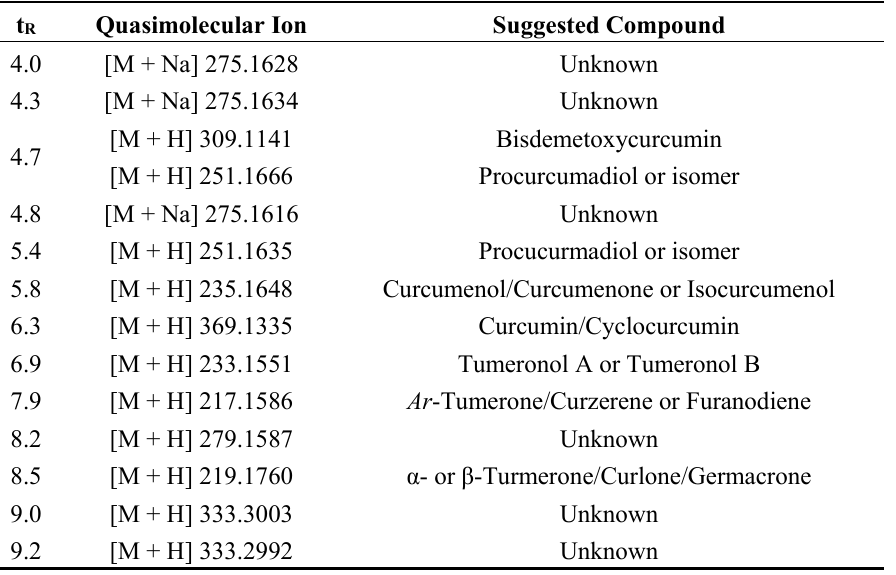
Figure A1. ID_14. Extract of Curcuma longa L. Table A3. Dereplication results for